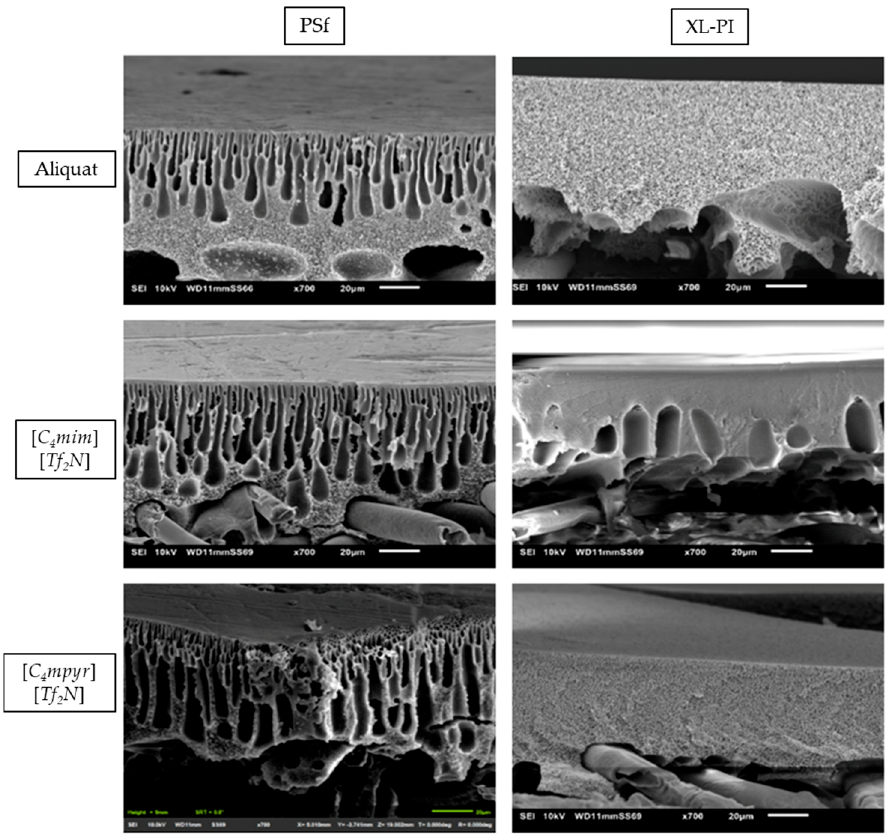
Figure 4. Cross-section scanning electron microscopy (SEM) images of the different membranes synthesized by using different ionic liquids (ILs) on the 2 types of support.